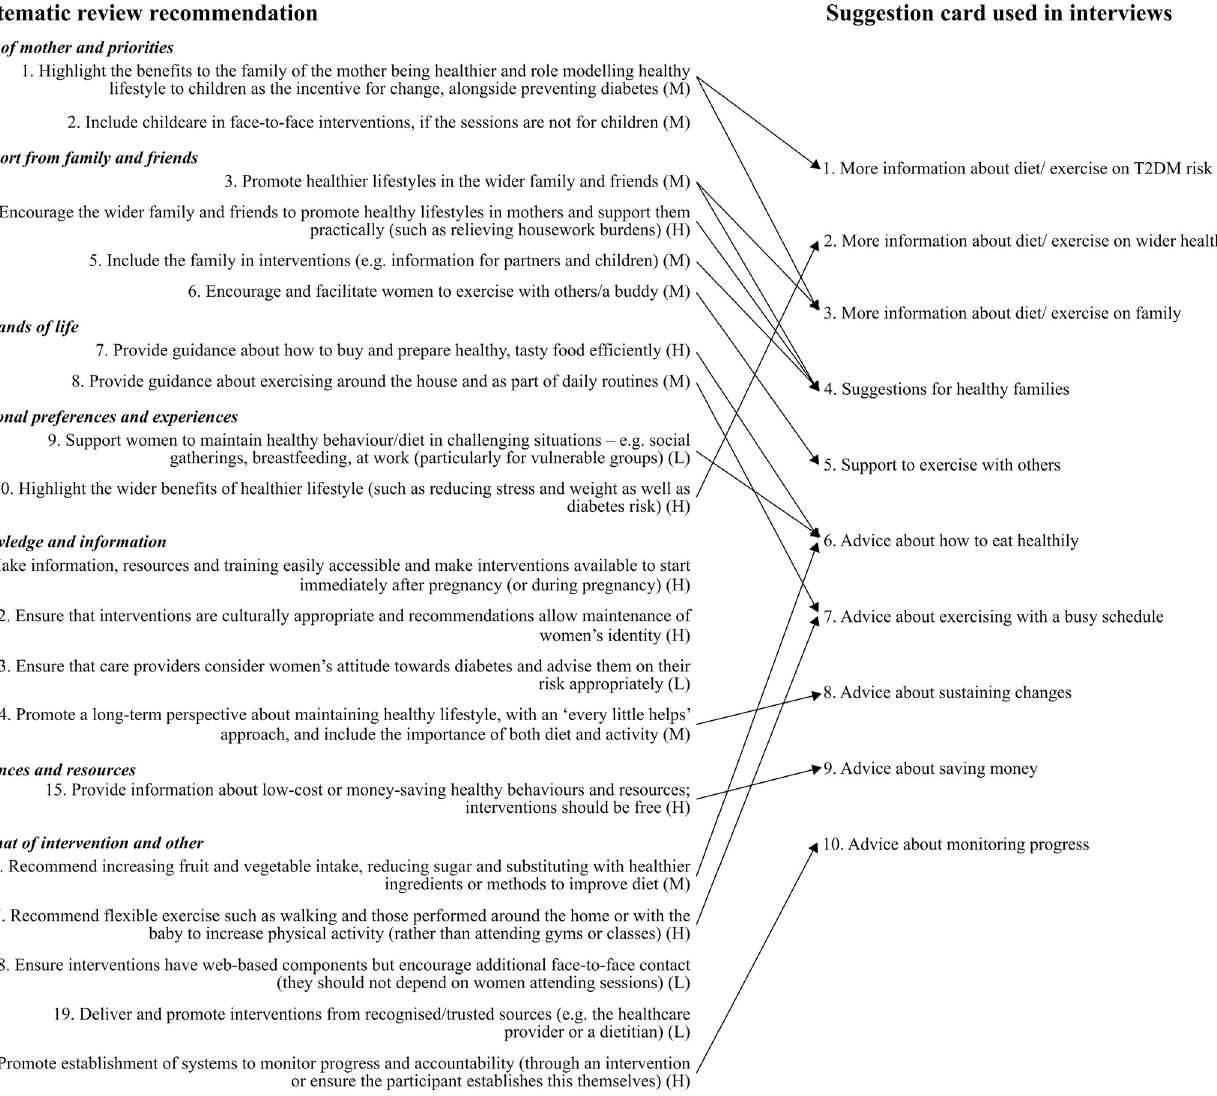
Fig 1. Adaptation of recommendations developed in the qualitative synthesis [17] to the DAiSIeS interview schedule. H: high confidence; M: medium confidence; L: low confidence in the recommendation in accordance with the GRADE-CERQual evaluation [24].